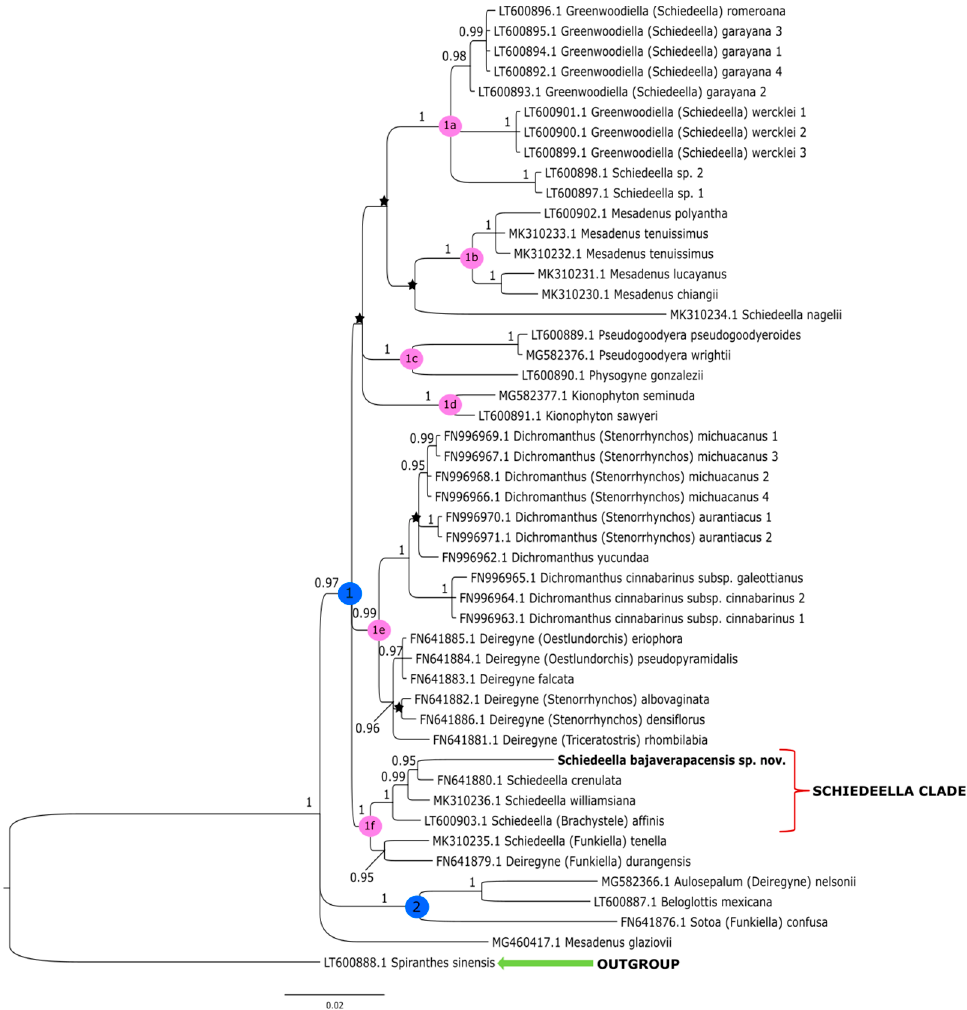
Figure 3. The phylogenetic tree presenting the position of Schiedeella bajaverapacensis sp. nov., obtained for the trn L- trn F region based on BI analysis. Posterior probability (PP) values are indicated above the branches and PP < 0.95 as an asterisk. While the numbers marked in circles on the nodes mean discussed clades.